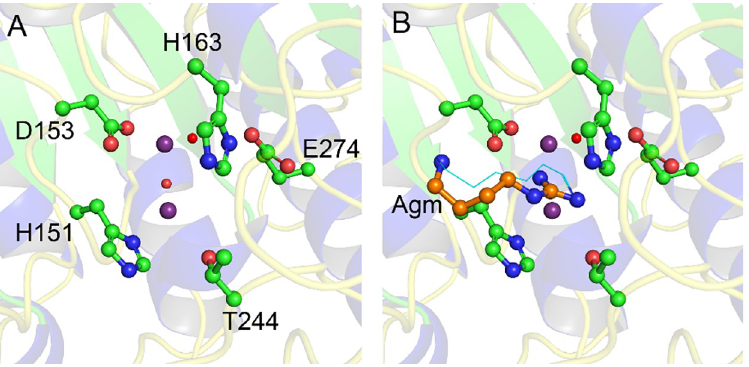
Fig 4. Active site of SPEB. The conserved active site residues of SPEB (A, chain A) are depicted in ball and stick representation with carbon atoms colored green, oxygen atoms colored red, and nitrogen atoms colored blue. Mn 2+ ions are shown as purple spheres, while two active site water molecules are included as red spheres. A putative model of agmatine binding to SPEB (B, depicted with carbon atoms colored orange and nitrogen atoms colored blue) was generated by superposition to the hexane-1,6-diamine ligand in 1WOG (B, cyan line drawing, see structure analysis in Materials and Methods). The position of agmatine illustrates that protein-ligand binding is likely governed predominantly by polar contacts with the guanidinium group. Refer to Fig 5B and 5C for details about hydrogen bonding pattern and distances in the active